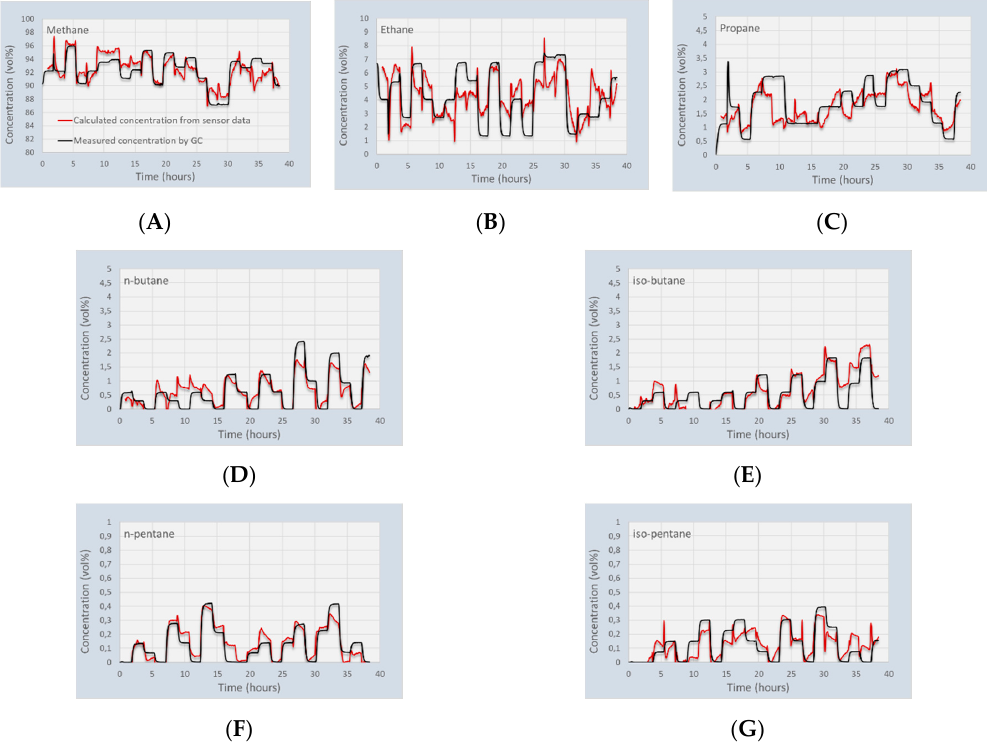
Figure 6. Calculated gas concentrations of the 7 gasses in the 22 gas mixtures of the validation experiment compared to GC data. The concentrations were calculated using the calibration data from Section 4.1. ( A ) Methane; ( B ) Ethane; ( C ) Propane; ( D ) n-butane; ( E ) iso-butane; ( F ) n-pentane; ( G ) iso-pentane.